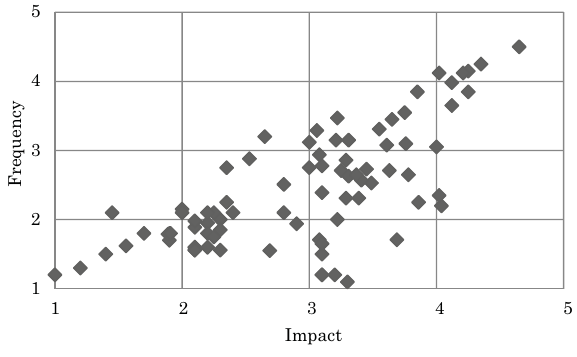
Fig. 2. Frequency-Impact